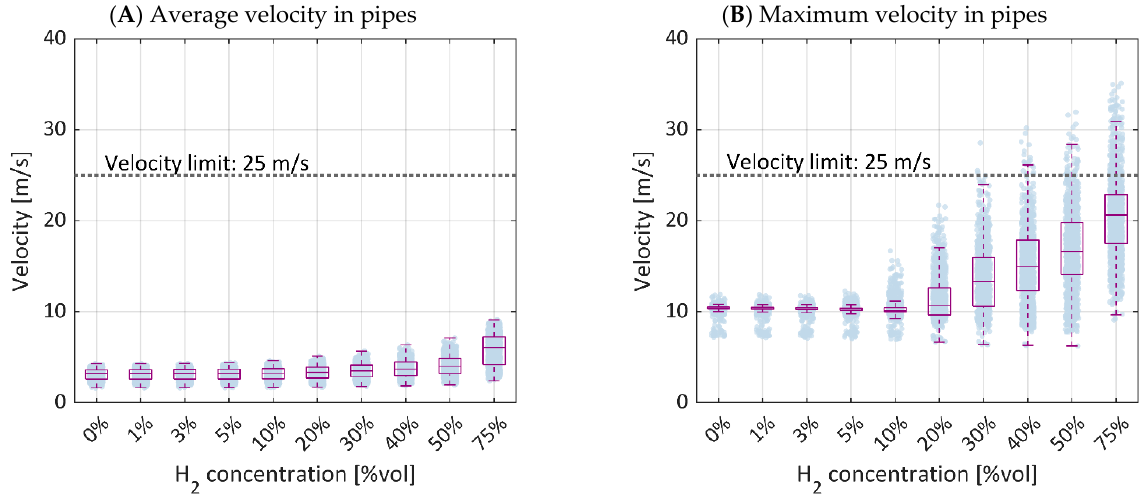
Figure 10. Evolution of average ( A ) and maximum ( B ) gas velocities recorded in 1000 networks at increasing H 2 concentrations—pure H 2 injected within the network.